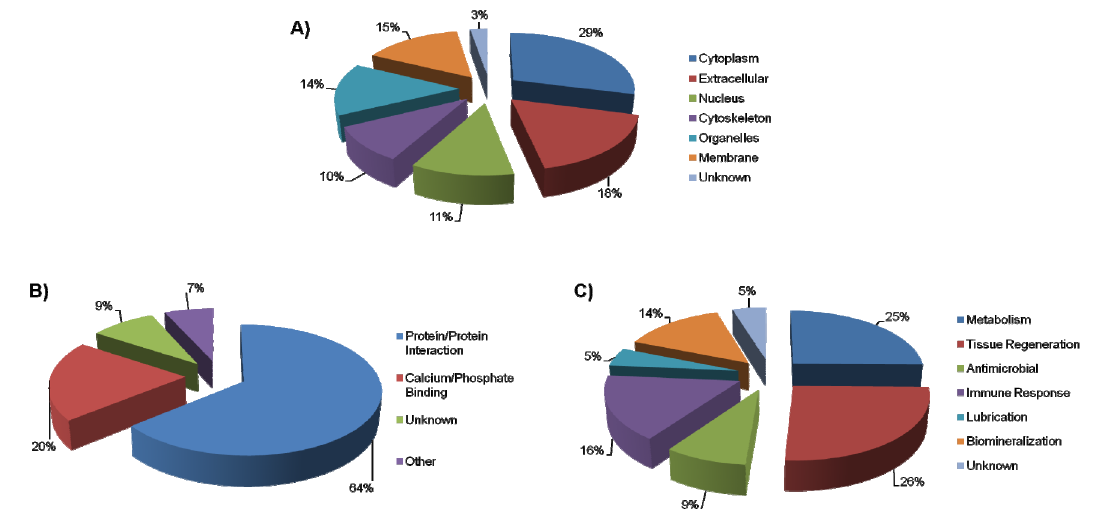
Figure 2. Classification of the in vivo deciduous AEP proteins according to ( A ) origin, ( B ) molecular interaction, ( C ) biological function. The area of each sector is directly proportional to the number of proteins in the deciduous AEP proteome that corresponds to each specific